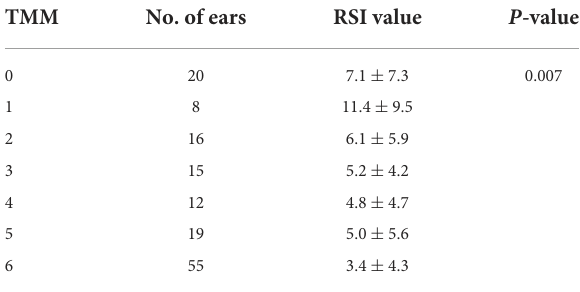
TABLE 2 The TMM value distribution of all 145 affected ears and corresponding RSI